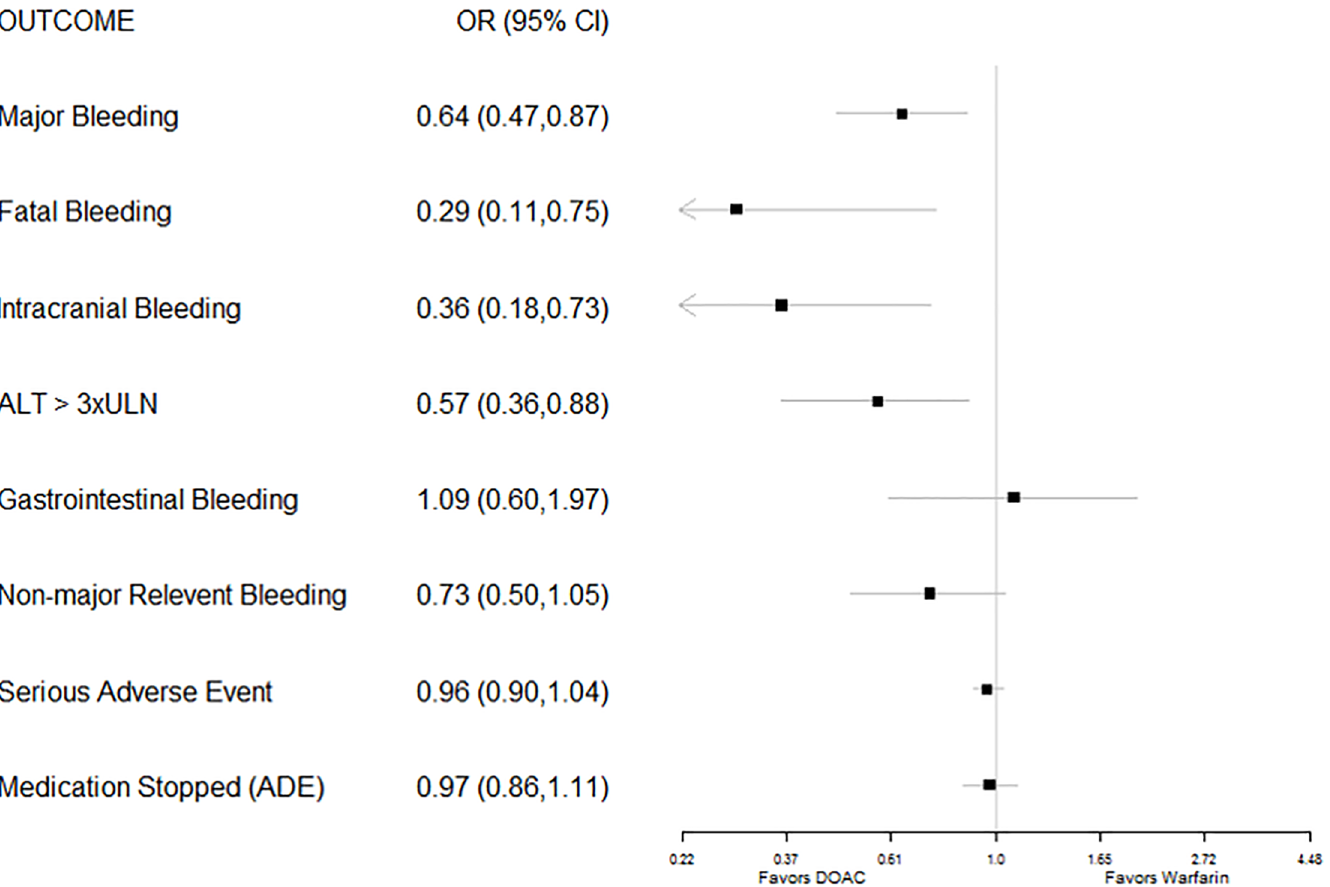
Fig 5. Forest plot of pooled odds ratios (with 95% CI) of various adverse drug events for FDA-approved direct oral anticoagulants versus warfarin for treatment of VTE.